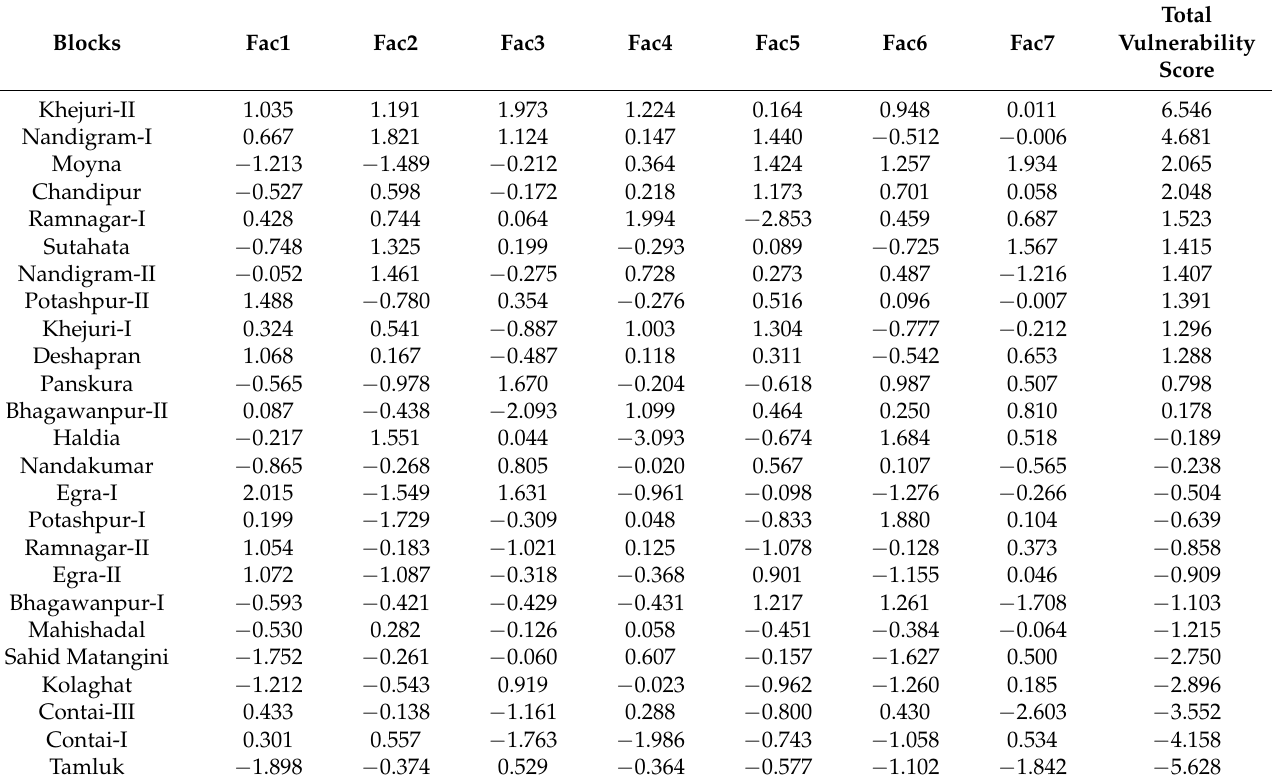
Table 6. Vulnerability score of seven factors for twenty-five blocks of Purba Medinipur